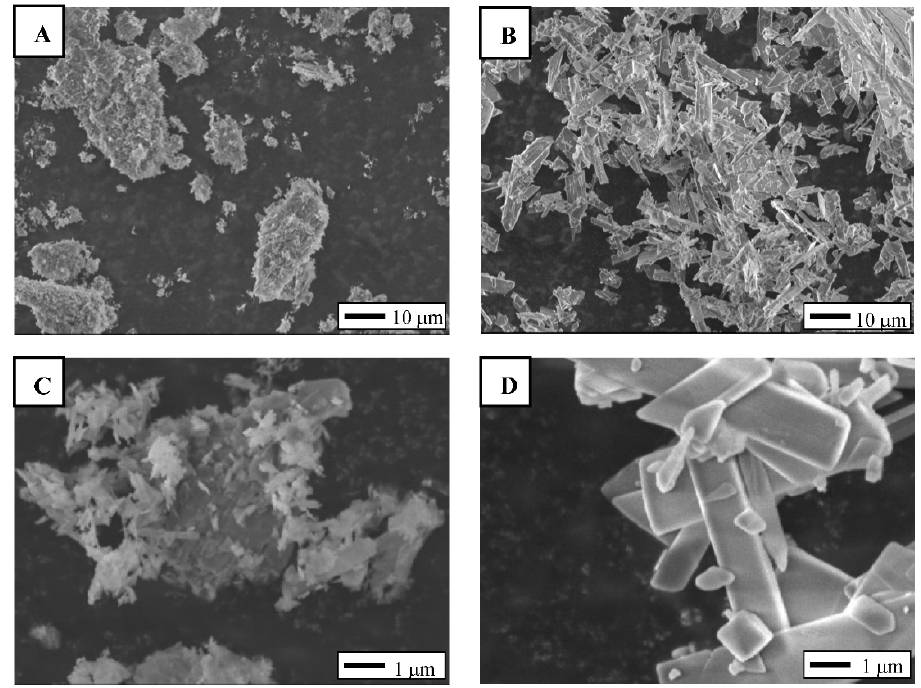
Figure 1. FE-SEM images of F-OCP ( A , C ) and C-OCP granules ( B , D ) at lower ( A , B ) and higher magnifications ( C , D ). Bars = 10 μ m ( A , B ) and 1 μ m ( C , D ). magnifications ( C , D ). Bars = 10 µ m ( A , B ) and 1 µ m ( C , D